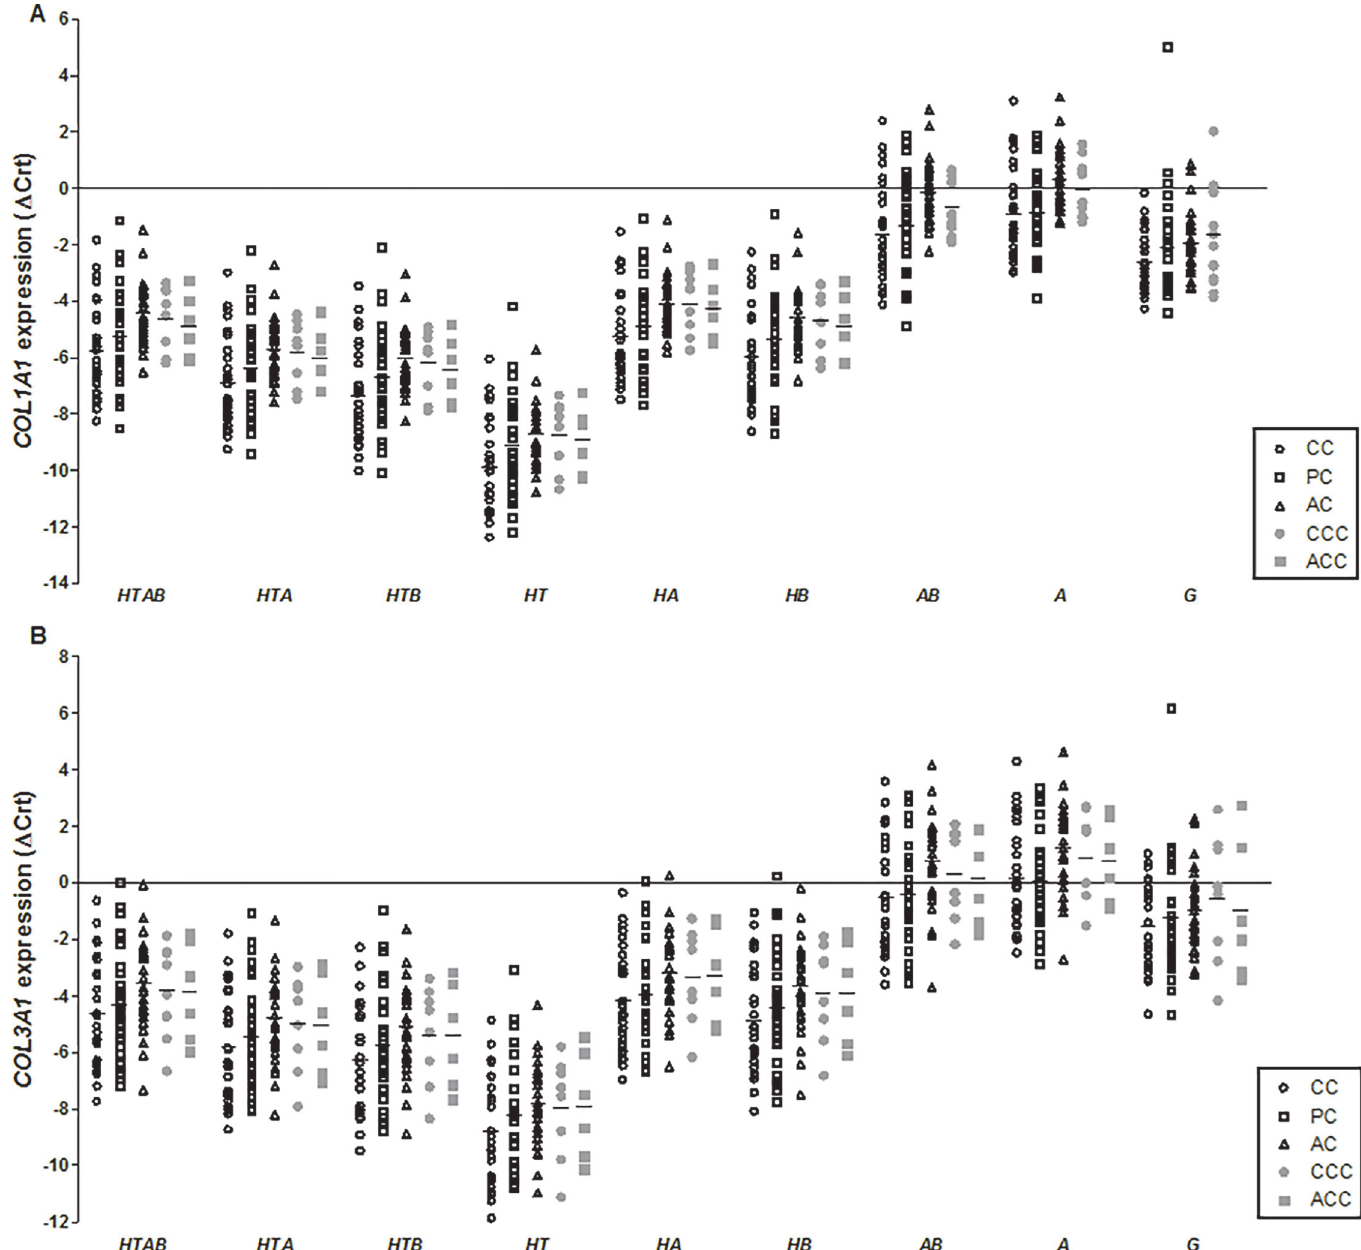
Fig 3. COL1A1 (A) and COL3A1 (B) expression normalized by different combinations of candidate reference genes in tendons specimens. HTAB: collagen expression normalized by HPRT1 + TBP + ACTB + B2M ; HTA: collagen expression normalized by HPRT1 + TBP + ACTB ; HTB: collagen expression normalized by HPRT1 + TBP + B2M ; HT: collagen expression normalized by HPRT1 + TBP ; HA: collagen expression normalized by HPRT1 + ACTB; HB: collagen expression normalized by HPRT1 + B2M ; AB: collagen expression normalized by ACTB + B2M ; A: collagen expression normalized by ACTB ; G: collagen expression normalized by GAPDH ; CC: central cuff (injured supraspinatus tendon) samples of cases; PC: posterior superior cuff samples of cases; AC: anterior cuff samples of cases; CCC: central cuff samples of controls; ACC: anterior cuff samples of controls.